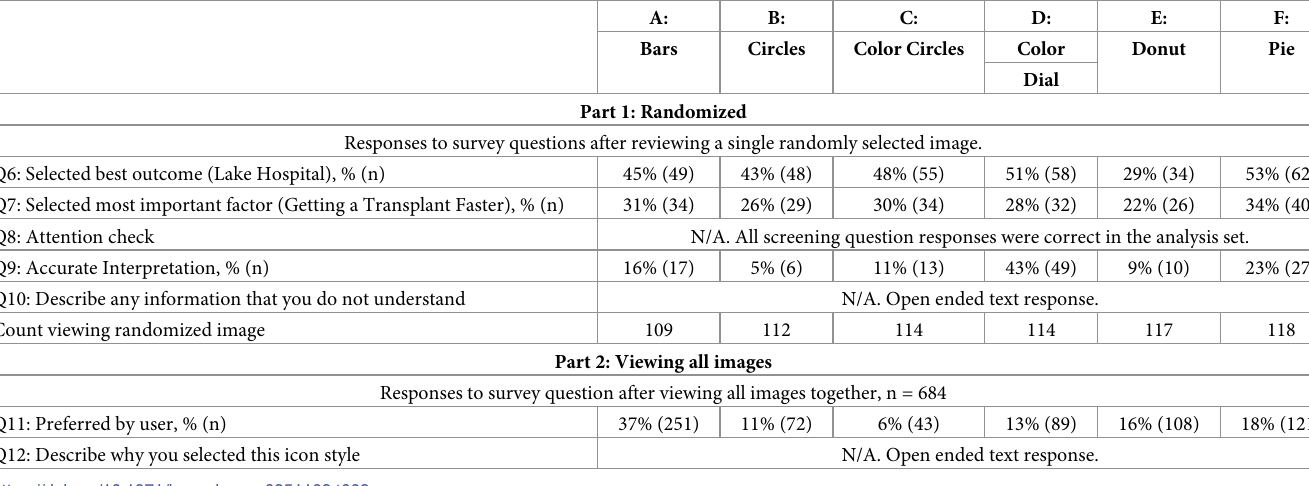
Table 2. Survey responses for the analysis set: The data consisted of 2 parts. A first part presented a single randomized image and a series of questions only relating to a single image. A second part presented all images together and followed with a question about all images.